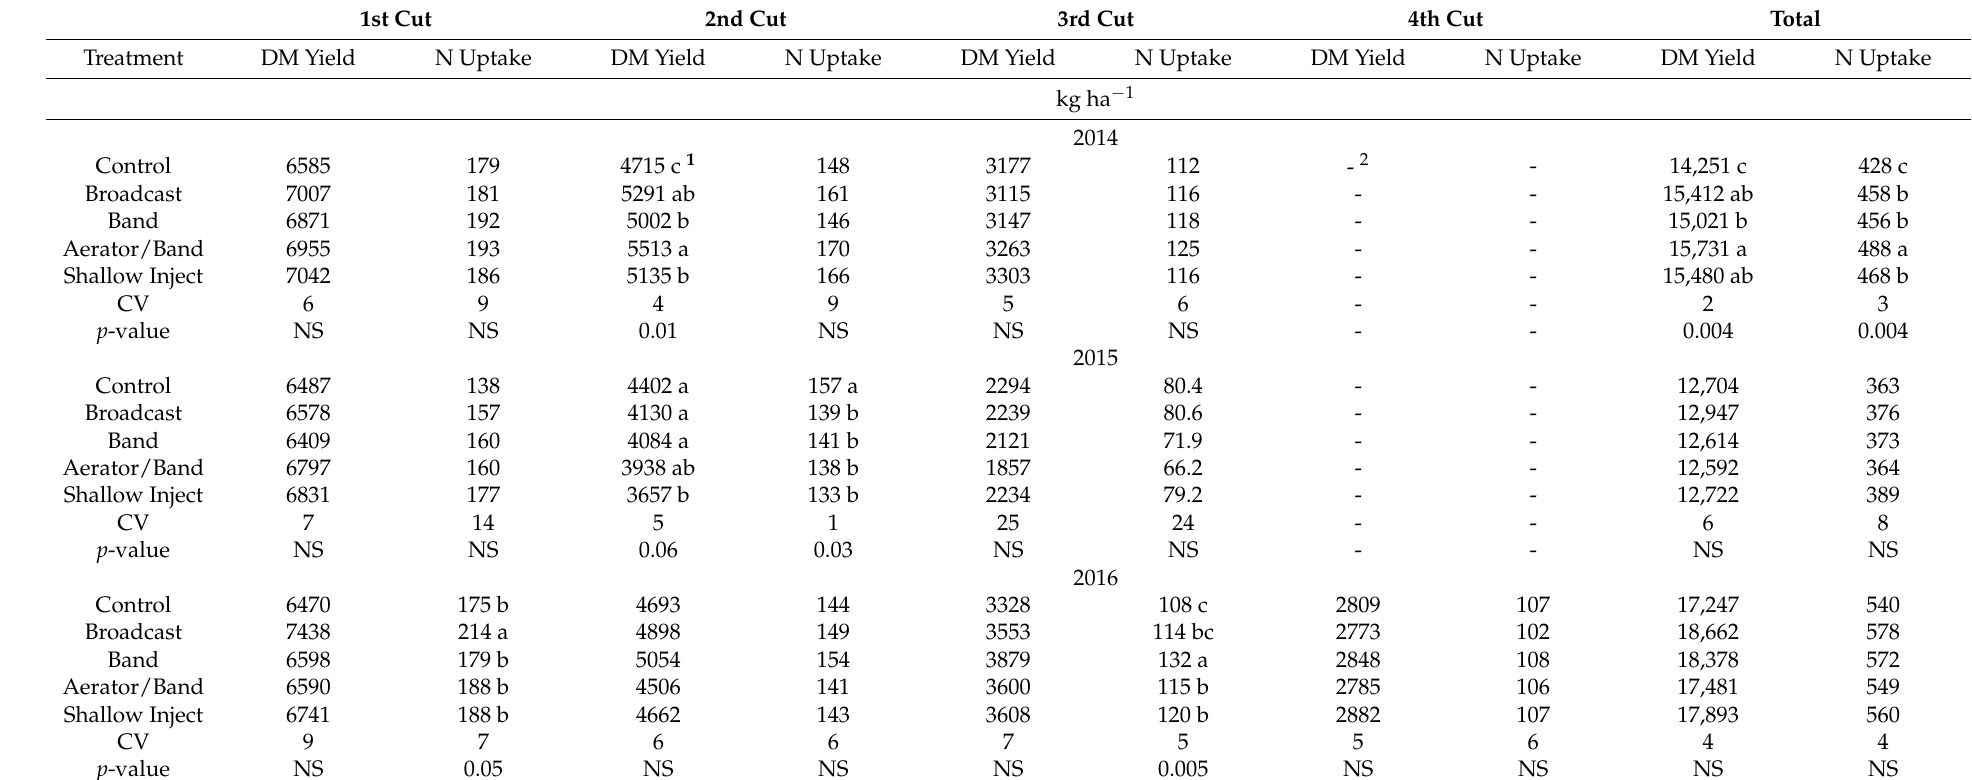
Table 2. Alfalfa dry matter (DM) yield (kg ha − 1 ) and nitrogen uptake (kg ha − 1 ) by harvest and